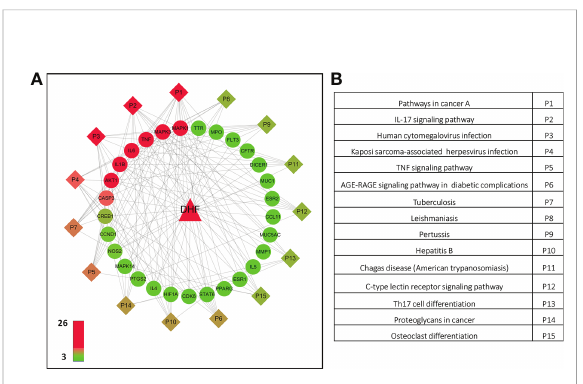
FIGURE 3 Compound-target- pathway-disease network of DHF for EoE. (A) By computational modeling, the role of DHF was deciphered through the drug-target network, and the target-disease network from the molecular level to the systems level. Triangle, circle, and diamond represent DHF, key targets and pathways, respectively. Node color from green to red is proportional to its degree. Black lines stand for interaction between the nodes The most important targets were TNF, MAPK1, MAPK3, IL6, IL1B, AKT1 and CASP3 (Red). The most important pathways associated with the protein targets were “ Pathways in cancer ” (P1), “ IL-17 signaling pathway ” (P2), and “ Human cytomegalovirus infection ” (P3). (B) Pathways associated in the compound-target-disease